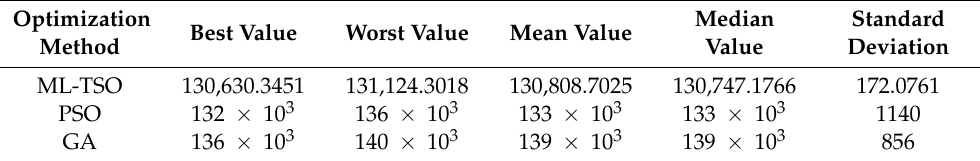
Table 9. The best, worst, mean, median, and standard deviation values in the case of the 118-bus system.